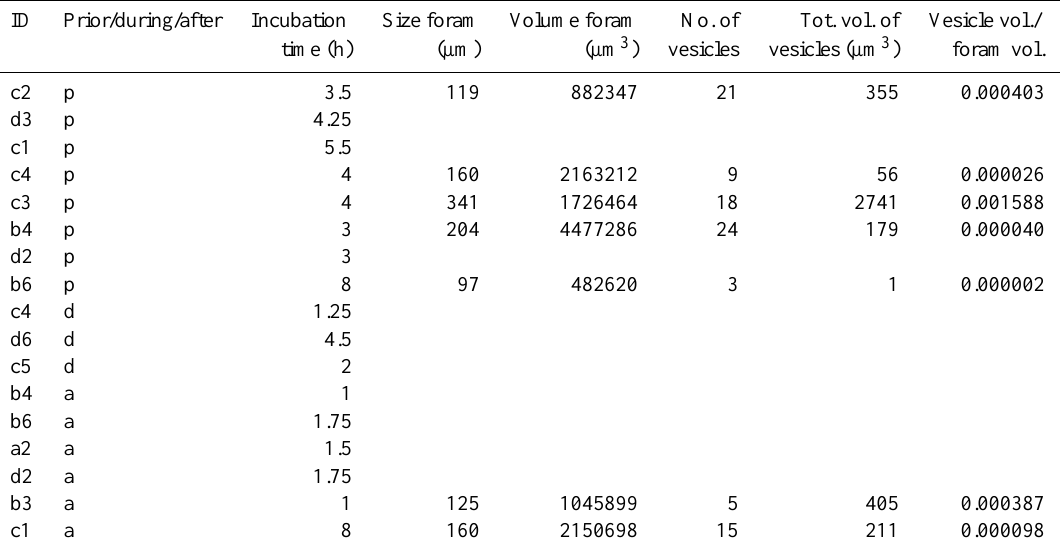
Table A1. Experimental details and results of the fluorescent labeling experiments.